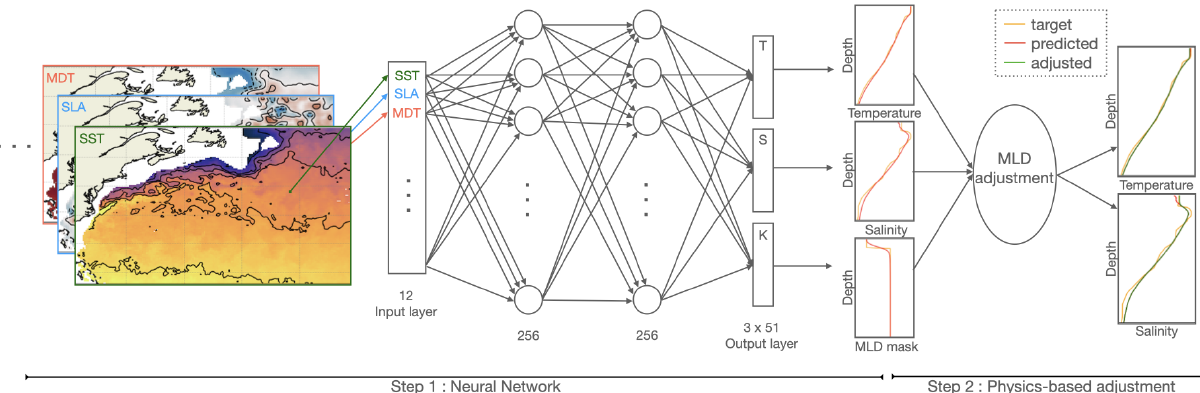
Figure 2. Schematic of OSnet formed of a neural network (NN) with two hidden layers and a mixed-layer (MLD) depth adjustment. The NN uses 12 surface inputs that are listed in Table 1 to predict profiles of temperature ( T ), salinity ( S ) and MLD mask ( K ). T − S profiles are then adjusted using the profile K for a better prediction of the